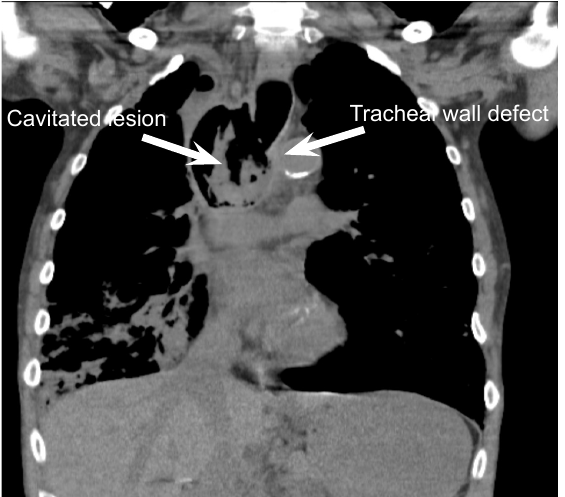
Figure 1. Anteriorposterior chest radiograph displaying lucency adjacent to the aortic knob (arrow) and left cardiac border (ar- rowhead) consistent with pneumomediastinum.